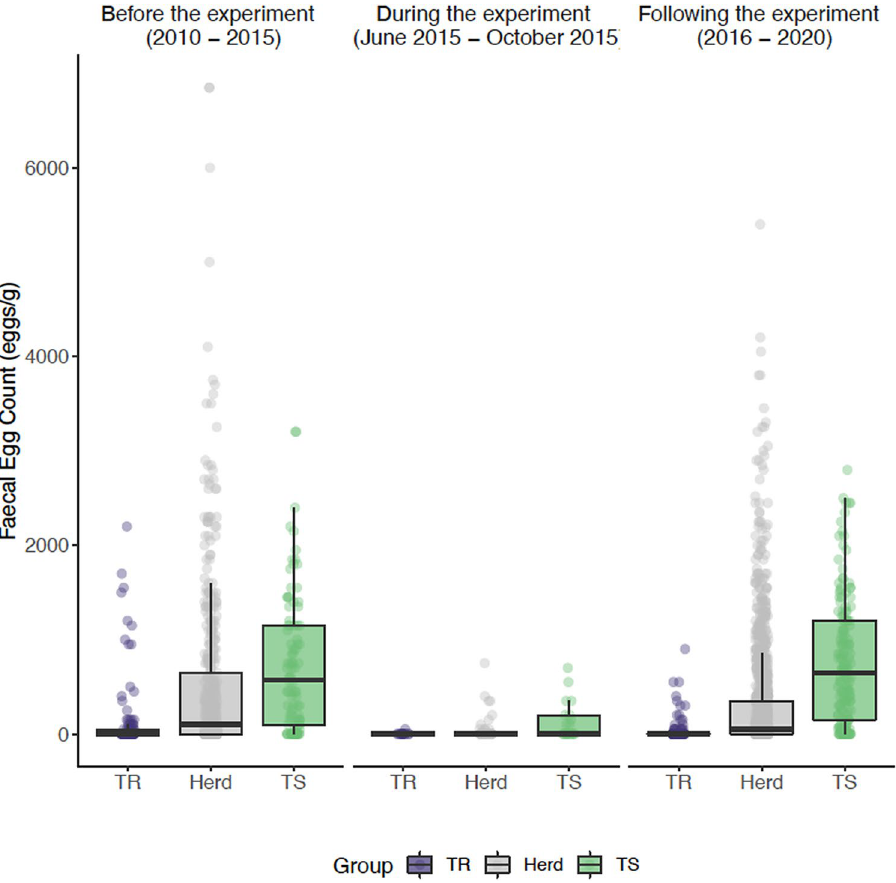
Figure 1. FEC-informed pony potential prediction is robust through time. The distribution of observed faecal egg counts before the experiment (2010–2015), during the experiment (2015) and after the experiment (2015– 2020) in the predicted susceptible (8 individuals, 271 records; green) and resistant (9 individuals, 223 records; purple) ponies and their herd unselected counterparts (127 individuals, 1436 measures; grey) is represented. Dots stand for individual measures and boxplots represent the data distribution (mean materialized by a vertical bar within the box that stands for the 25–75% interquartile